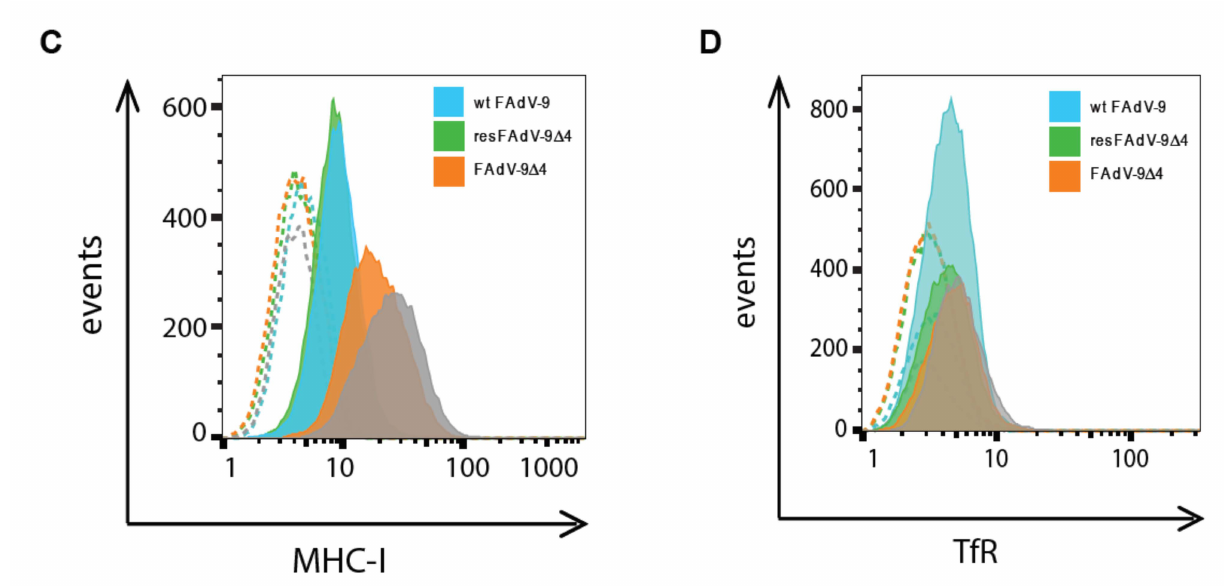
Figure 2. Role of the left-most transcription unit of FAdV-9 in regulating cell surface MHC-I and TfR. ( A ) The lower two ORF maps are schematic diagrams showing the left end genomic regions of FAdV-9 (and resFAdV-9 ∆ 4) and FAdV-9 ∆ 4. The dark grey arrows indicate the position and direction of transcription for the predicted ORFs, inverted terminal repeats are indicated by ITR. The transcripts resulting from alternative splicing, as previously reported [5] are shown above, to scale, with bold lines and light grey arrows representing exons and bent lines depicting introns. The 5 (cid:48) -m7G caps and polyadenylation signals are included for clarity. A dashed line indicates the genomic region that was deleted from FAdV-9 ∆ 4 (nts 491-2782), resulting in the complete removal of the leftmost transcription unit [7]. ( B ) Cell surface expression of MHC-I on CH-SAH cells was analyzed using flow cytometry at the times post infection indicated. The graphs present averages and standard deviations of the means obtained from three independent experiments and are shown as percentages of expression relative to mock-infected cells at each time point, which maintained initial levels of expression (100%). Background fluorescence was determined with an isotype control FITC-conjugated antibody for each treatment and subtracted. In some instances the errors were smaller than the symbols used in the graphs and are therefore not visible. An asterisk (*) indicates a significant difference ( p < 0.05) by Student’s T test in comparison to the other two groups. ( C ) Cell surface expression of MHC-I on LMH cells was analyzed using flow cytometry at 12 h.p.i. after mock infection (grey) or infection with FAdV-9 ∆ 4 (orange), FAdV-9 (blue), and resFAdV-9 ∆ 4 (green) at an MOI of 5. Primary anti-MHC-I MAb F21/2 was used, followed by FITC-conjugated goat anti-mouse IgG. Live cells were gated on the basis of PI staining. Background fluorescence was determined with an isotype control FITC-conjugated antibody for each treatment (dashed lines). ( D ) Cell surface expression of TfR on CH-SAH cells was analyzed at 12 h.p.i. using flow cytometry after infection with FAdV-9 ∆ 4 (orange), FAdV-9 (blue), and resFAdV-9 ∆ 4 (green) at an MOI of 5. The dashed histograms depict the background staining obtained with isotype control FITC-conjugated